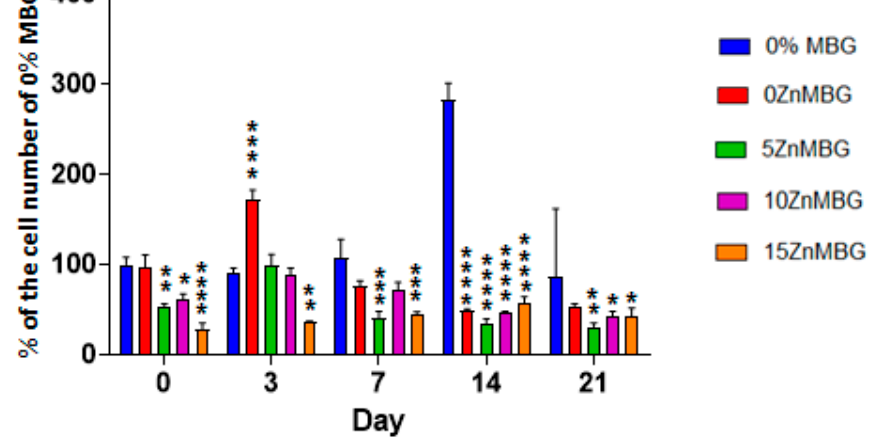
Figure 7. Development of number of MSC in bioprinted 3–9 composite scaffolds containing 7% of each ZnMBG and 3–9 algMC (MBG-free) scaffolds during 21 days of culture examined by quantifica- tion of DNA extracted from cells encapsulated in bioprinted constructs. Cell number development is represented as percentage of MBG-free (control) samples right after printing (day 0), * indicates significant difference with p < 0.05, ** with p < 0.01, *** with p < 0.001 and **** with p < 0.0001, in comparison to MBG-free constructs; Values are means ± SD, n = 3.